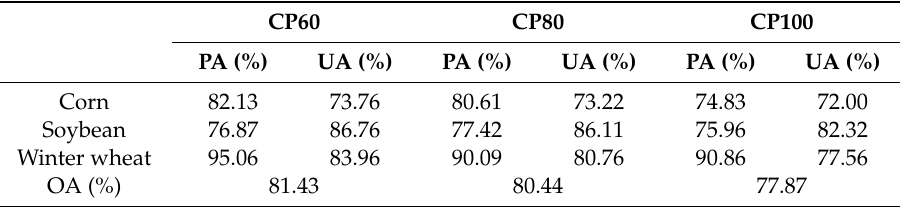
Table 6. Accuracy statistics with respect to different class purity values when using a 9 by 9 patch in Illinois (PA: producer’s accuracy; UA: user’s accuracy; OA: overall